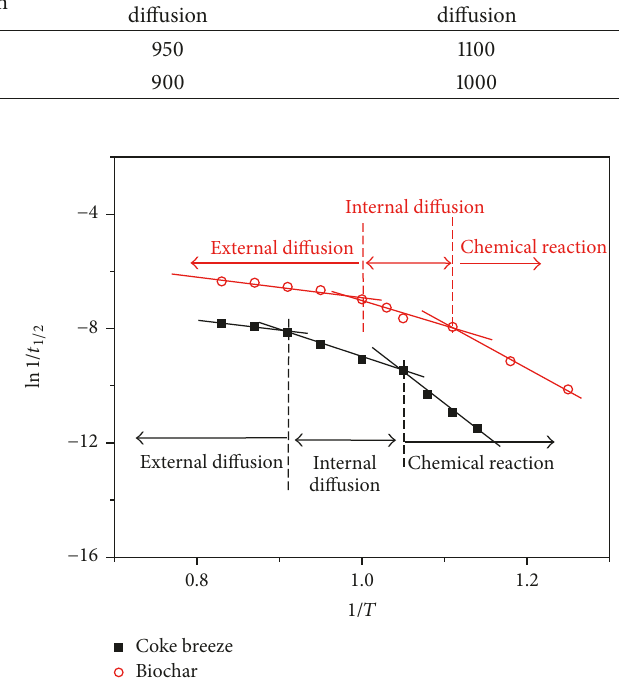
Figure5:Relationshipbetweenln 1/𝑡 1/2 and 1/𝑇